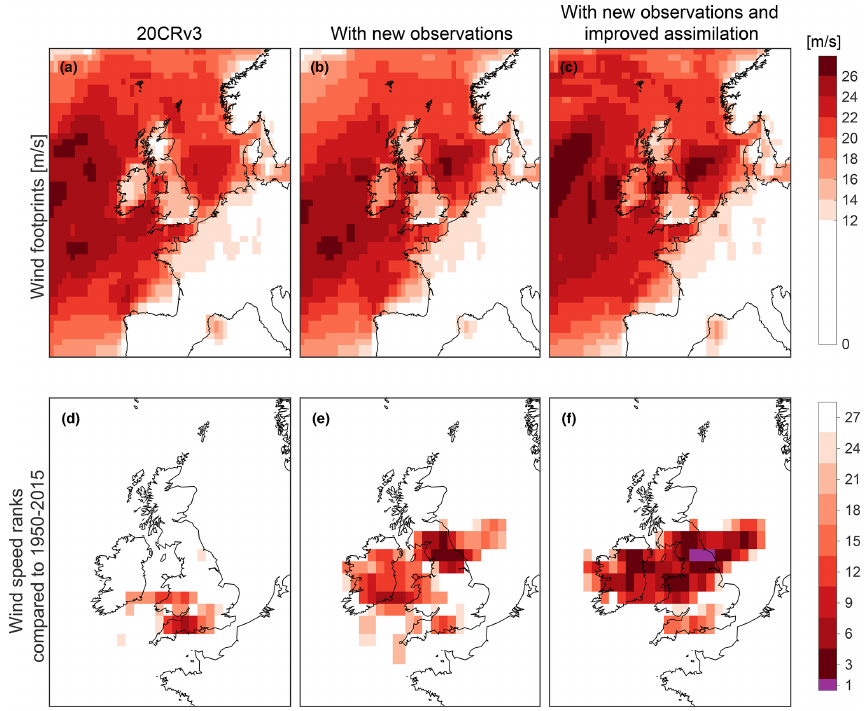
Figure 4. Comparing wind speeds with other events in the modern era. Wind footprints (top row, ms − 1 , a–c, the maximum 10m wind speed experienced at each location using instantaneous 3-hourly reanalysis data during the storm) and ranking of 10m wind speed compared to all events during 1950–2015 (bottom row, d–f) for Storm Ulysses. The columns show 20CRv3 and the two experiments with the reanalysis system. Purple colours indicate locations where Storm Ulysses would have been the strongest observed had it occurred during